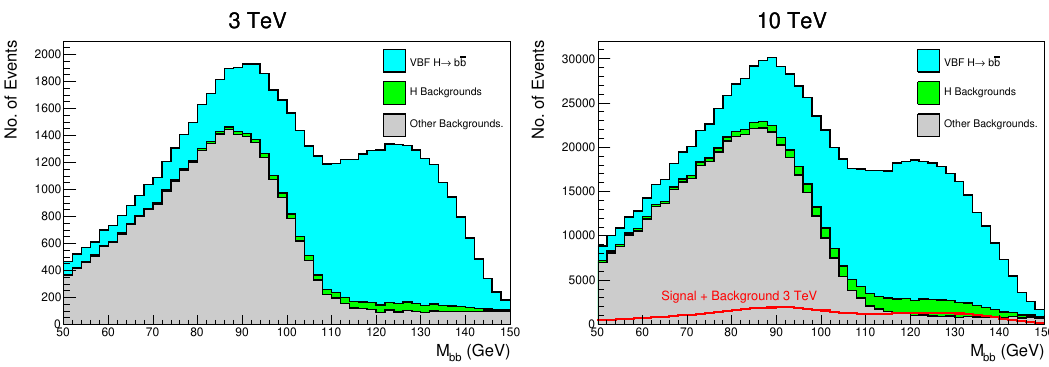
¯ Figure 4 . Stacked b b pair invariant mass histograms for the H → b b -tagging at (left) 3 TeV and (right) 10 TeV. The sum of signal and background at 3 TeV is overlayed on the 10 TeV plot for ease of